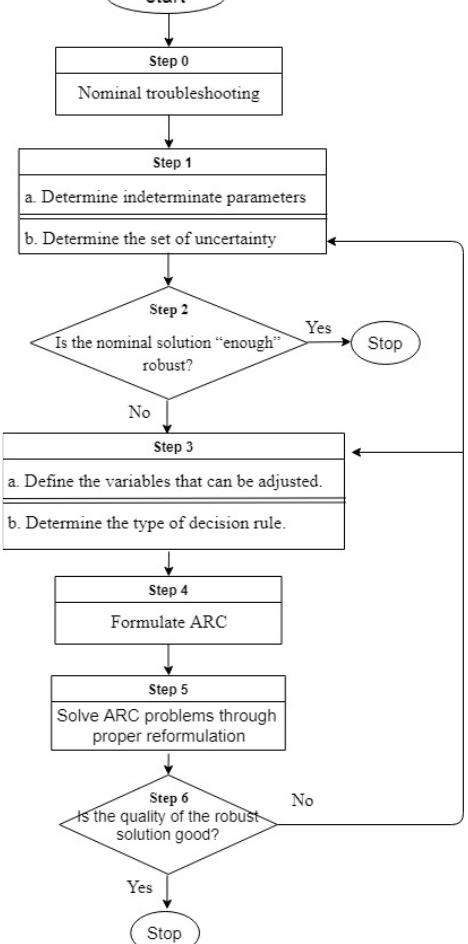
Fig. 1. ARC implementation